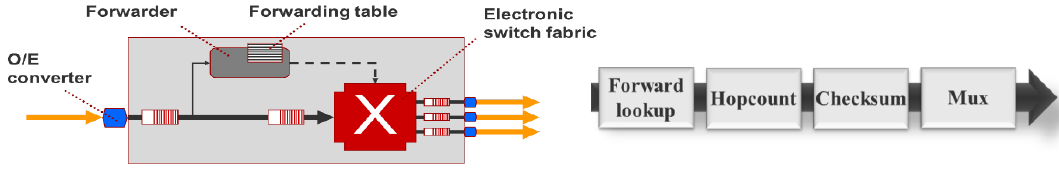
Figure 2. Basic data (thick lines) and control (thin) in an Internet router ( left ); and internal sequence ( right ).